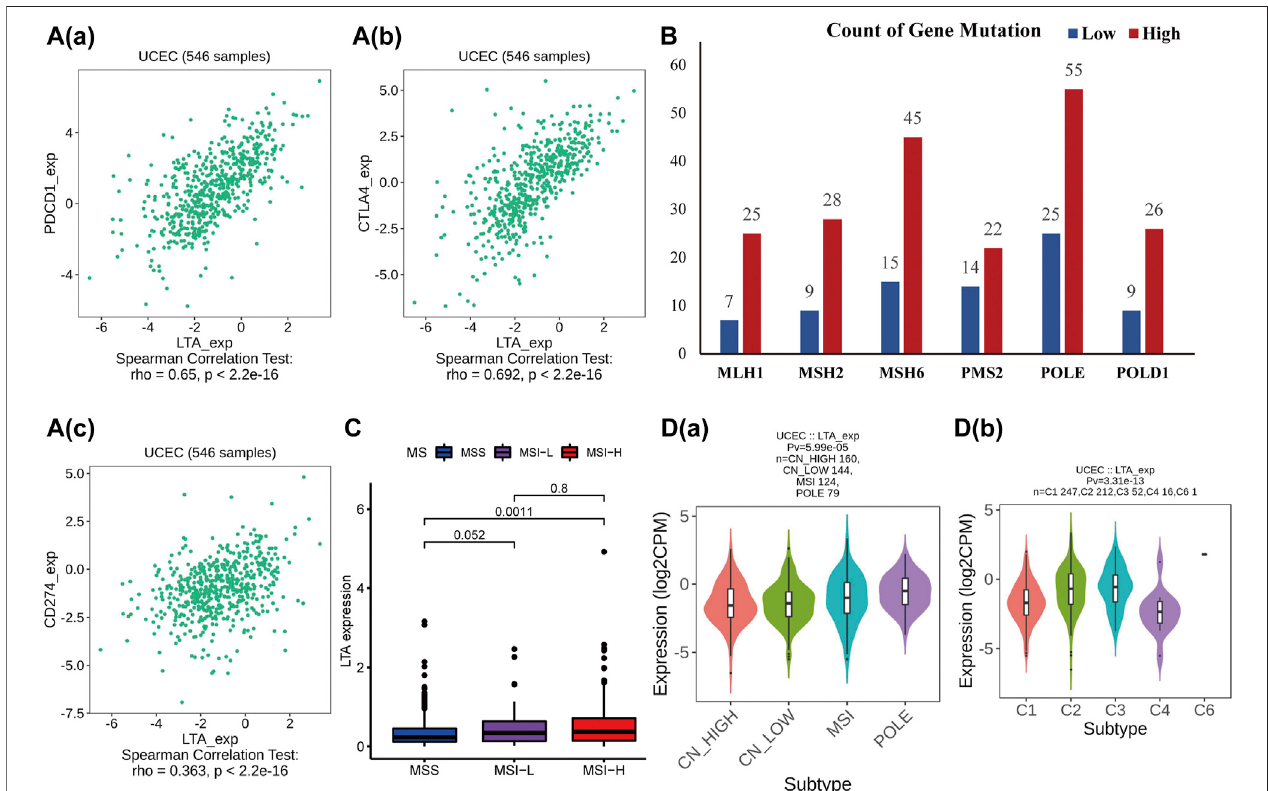
FIGURE 6 | Analysis of the relationships of LTA on immune status using TISIDB. (A) The correlation between LTA and PDCD1/PD1 (a) , CTLA4 (b) , and CD274/ PDL1 (c) . (B) Genemutationsassociatedwithmismatchrepair and POLEproofreadingdomainbetweenhigh-and low-LTA groups. (C) Differentialexpression ofLTAin three distinct microsatellite states. (D) The relationship of LTA on immune (a) and molecular (b) subtypes, respectively.